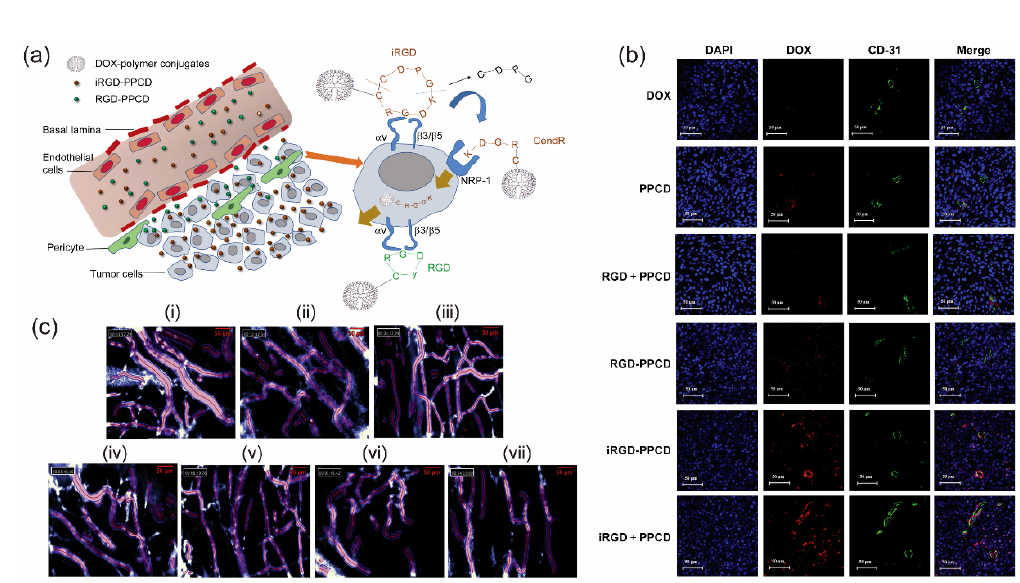
Figure 3. ( a ) Schematic elucidation of tumor penetrating characteristics of iRGD-PPCD and